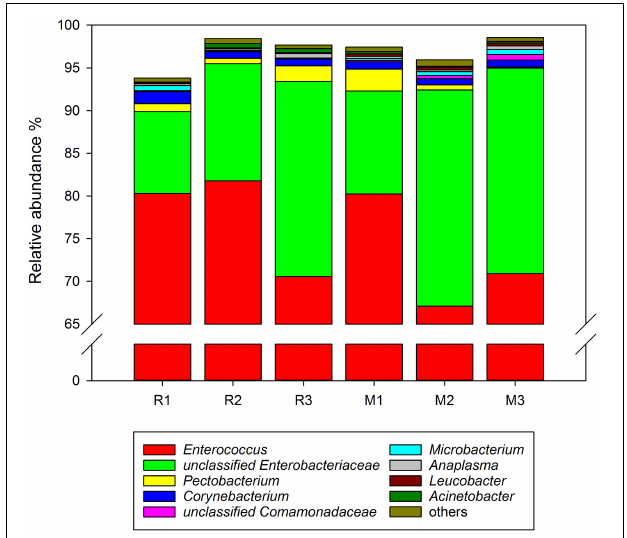
FIGURE 3 | Relative abundance of the genera in the gut microbiotas found in all samples of C. medinalis . R1–R3: the first to third generation of C. medinalis fed rice; M1–M3: the first to third generation of C. medinalis fed maize.